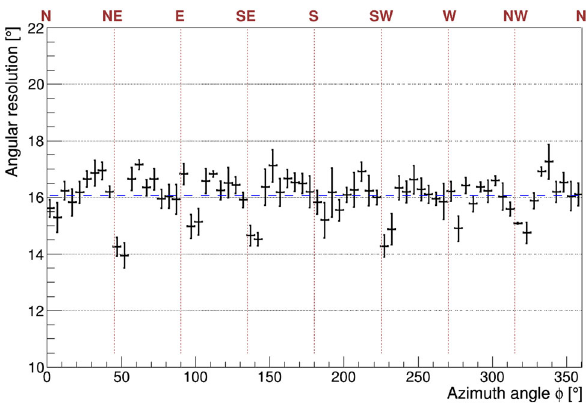
Fig. 6 Azimuth angle resolution of the Muon Monitor as the func- tion of the azimuth angle. The blue dashed line represents the global